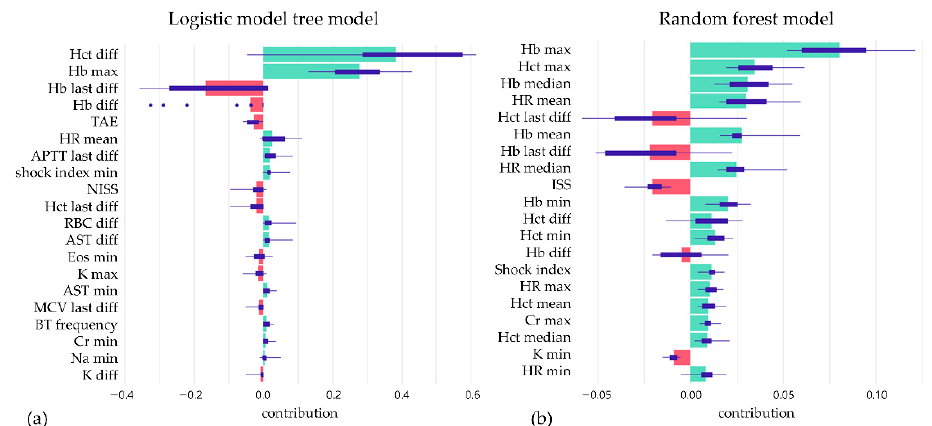
Figure 4. The box plots summarize the distribution of contributions of features in each model by SHAP value; ( a ) logistic model tree model and ( b ) random forest model.